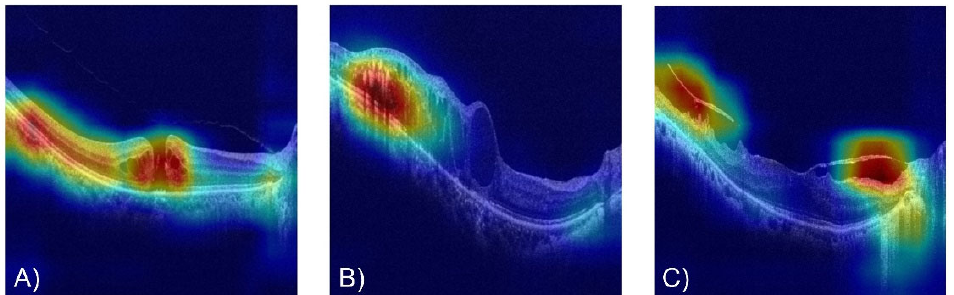
Figure 4. Representative visual explanations of the feature map of the CNN model in the corrected OCT image. The heat maps in ( A ) macular hole, ( B ) macular edema, and ( C ) epiretinal membrane indicate the relative activation intensity of predicting abnormalities in the OCT images. Warm colors indicate areas of high attention for classification. The CNN model made a decision based on the location of the warm color. The CNN model focused on the retinal structural changes in the abnormal eyes. Abbreviations: OCT, optical coherence tomography; CNN, convolutional neural